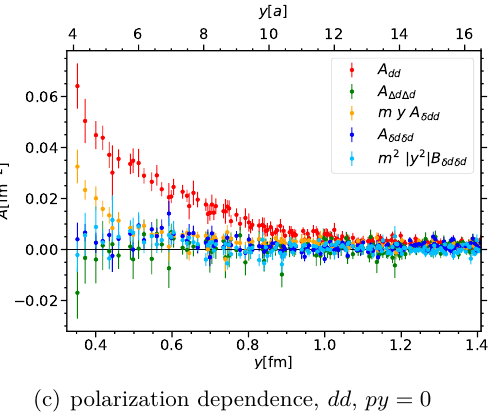
Figure 13 . Comparison of the results for different quark polarizations for the flavor combinations ud (a), uu (b) and dd (c) at py = 0